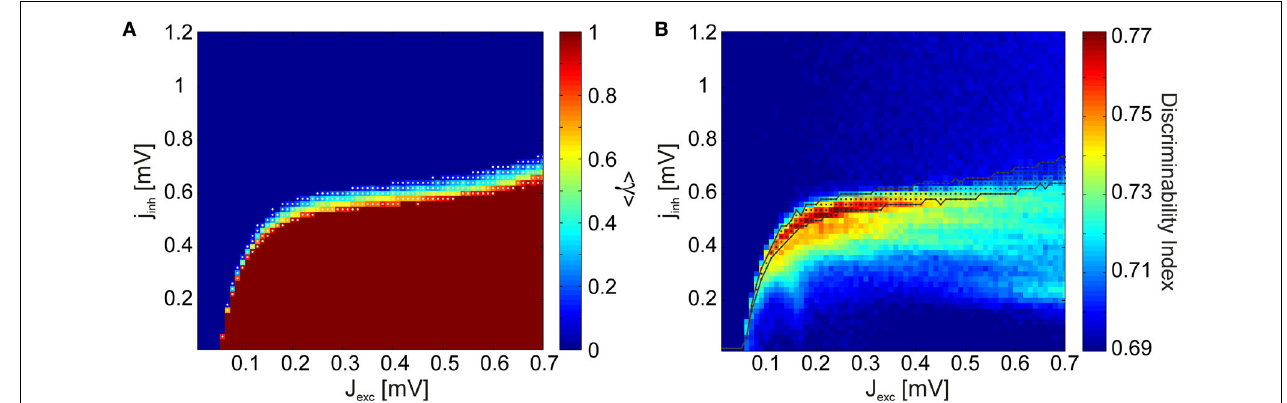
(cid:3) γ (cid:4) = 1. A phase transition from subcritical to supercritical dynamics takes place between these two regions, at different points for different stimuli. This transition region where 0 < (cid:3) γ (cid:4) < 1 is indicated by white dots. (B) Comparison of the discriminability index ( Figure 4A ) and the transition